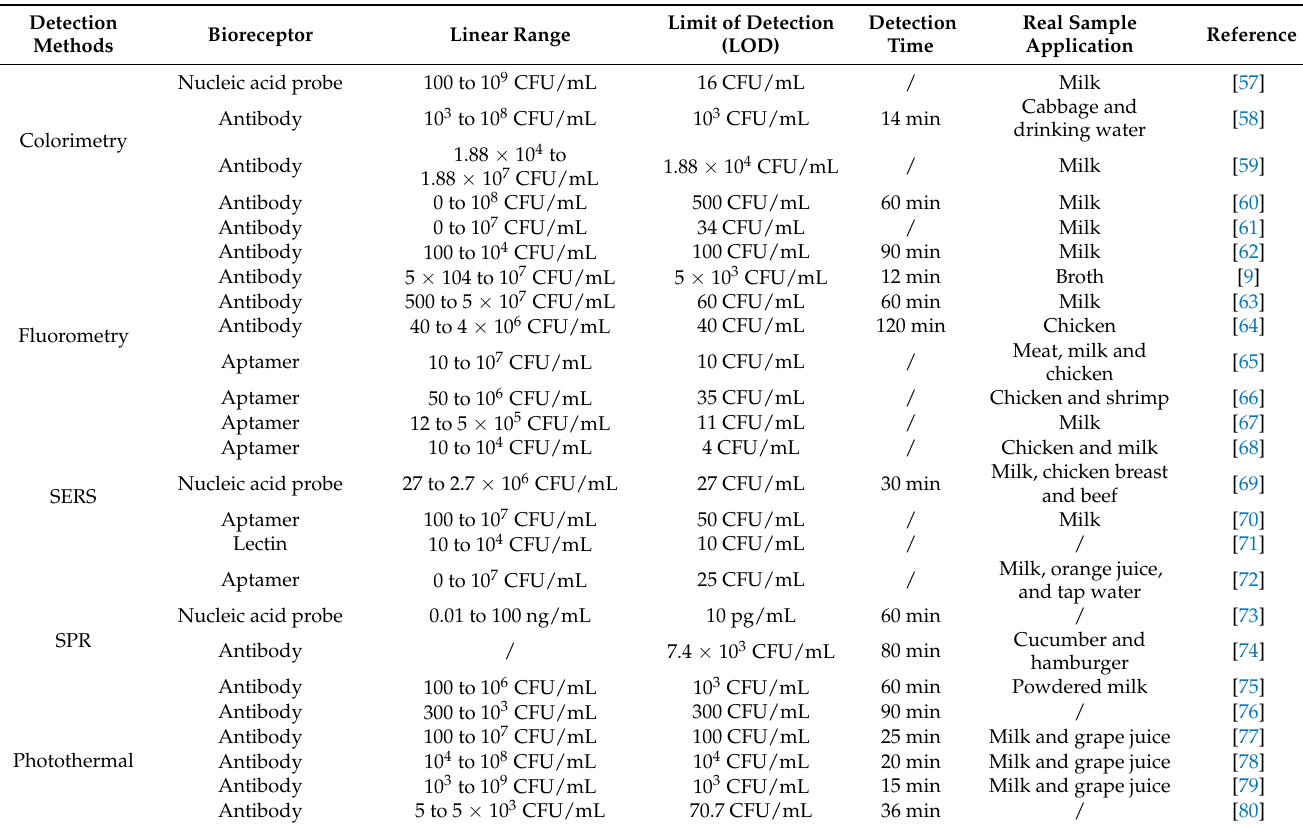
Table 2. Optical sensors reported for Salmonella